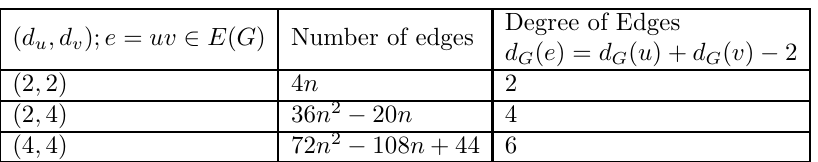
Table 3. Edge partition of Dominating David derived network of third